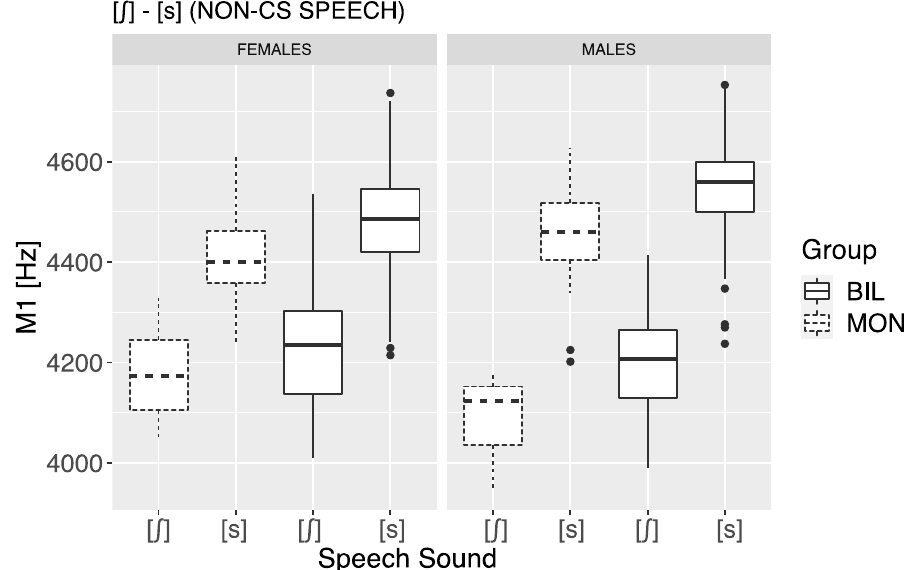
Figure 6. The first spectral moment of intended [ ʃ ] and [s] sounds in English words, spoken by MON speakers (dashed) and BIL speakers (solid) in non-CS speech. The left panel shows female data, the right panel male data.